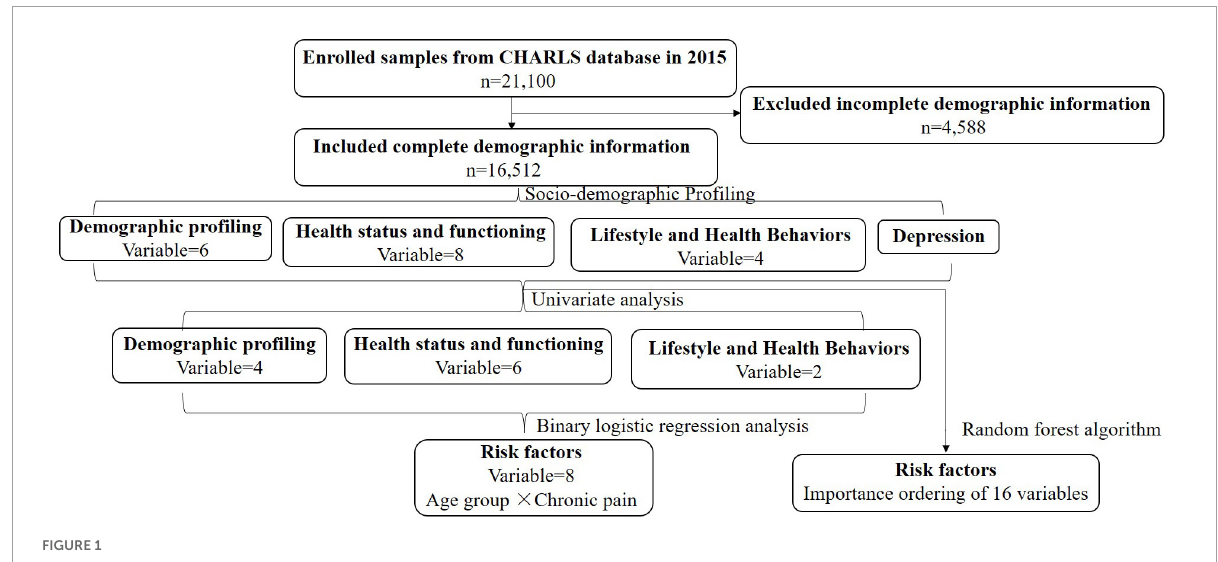
FIGURE1 The flowchart of the consecutive analysis steps.